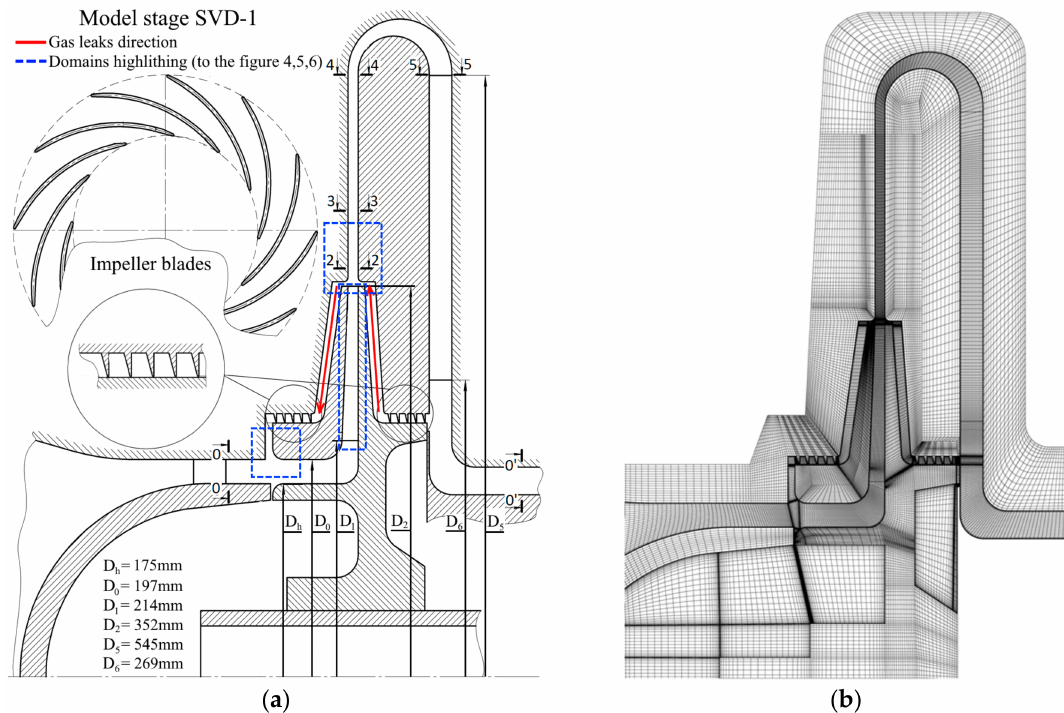
Figure 1. ( a ) Sketch of the model stage SVD-1 flow part and leakage diagram (red arrows); ( b ) The SVD-1 stage mesh model for conjugate heat transfer